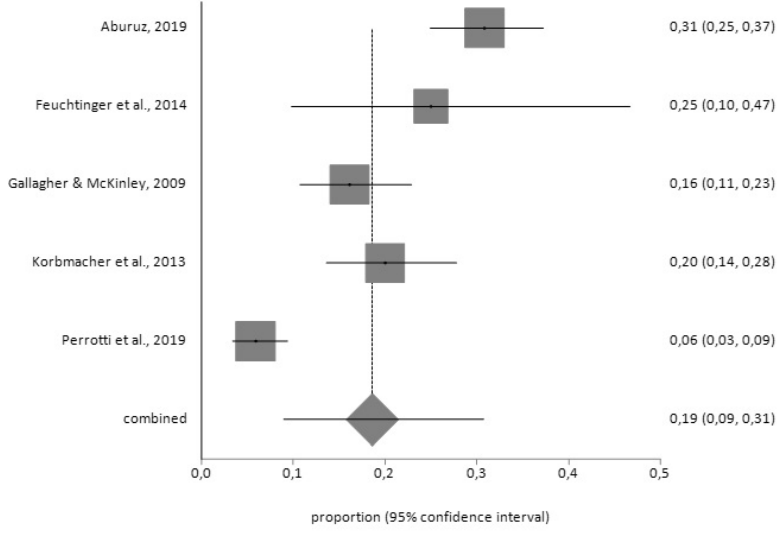
Figure 2. Forest plot for pre-CABG depression using Hospital Anxiety and Depression Scale (HADS).